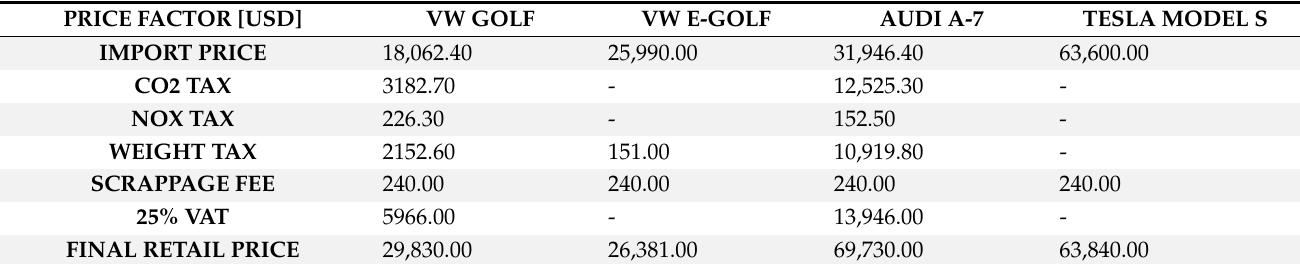
Table 3. The Retail Prices [USD] of BEVs Compared to Competitor Gasoline Vehicles in Norway, 2017